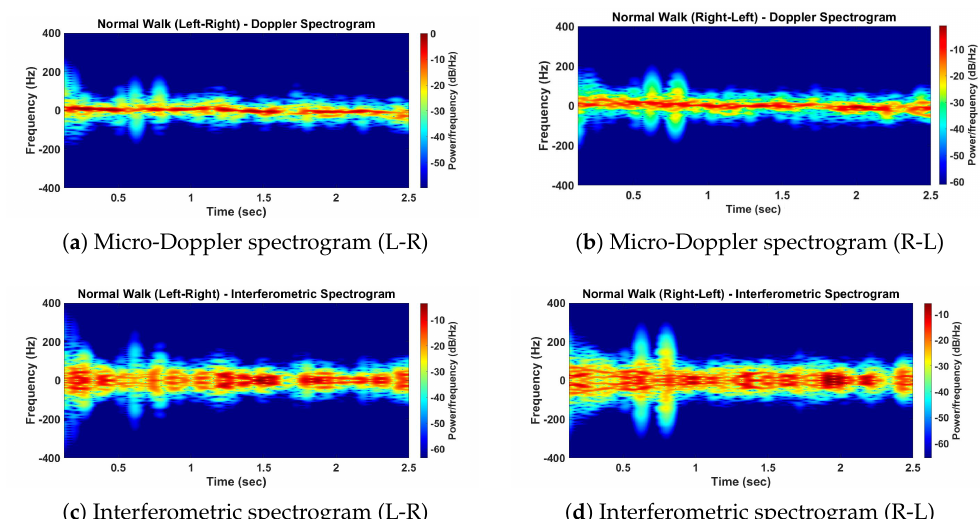
Figure 7. Dual micro-motion signatures of normal